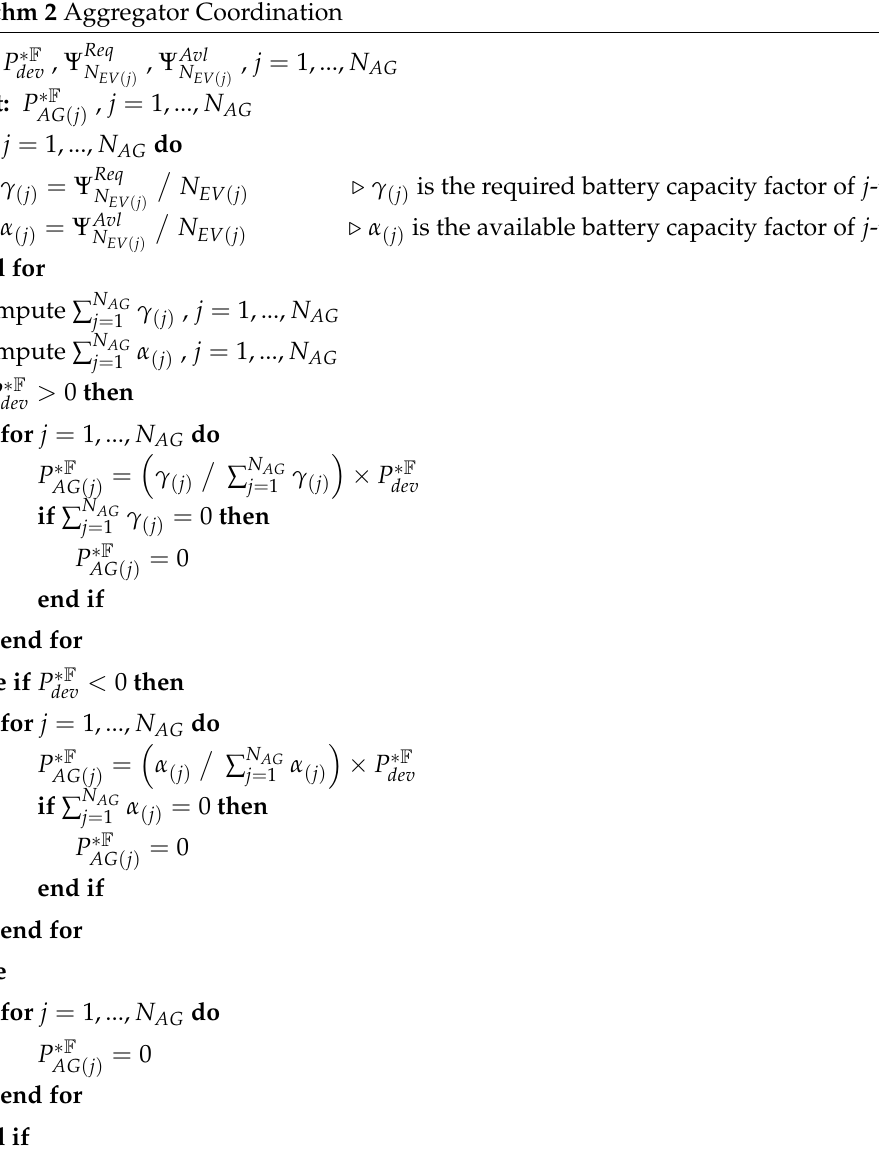
Algorithm 2 Aggregator